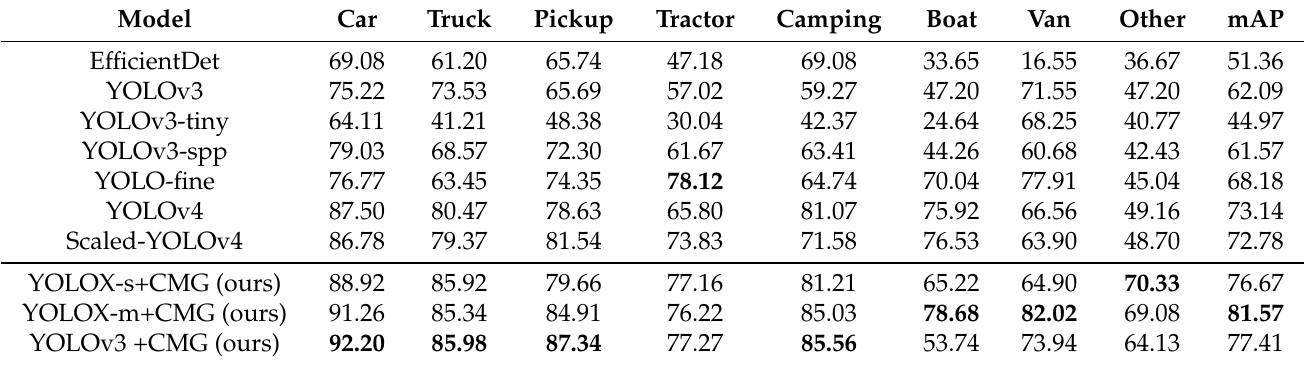
Table 6. Per-class performance of YOLOX backbones with CMG on VEDAI25 dataset. Our method outperforms the state-of-the-art for all